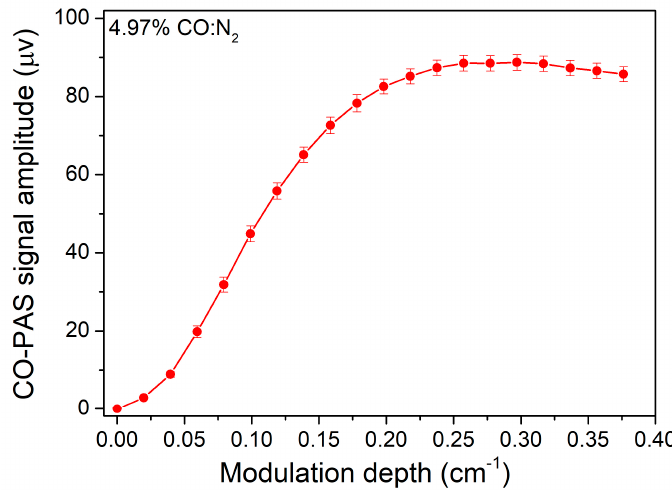
Figure 6. PAS signal amplitude as a function of modulation depth.